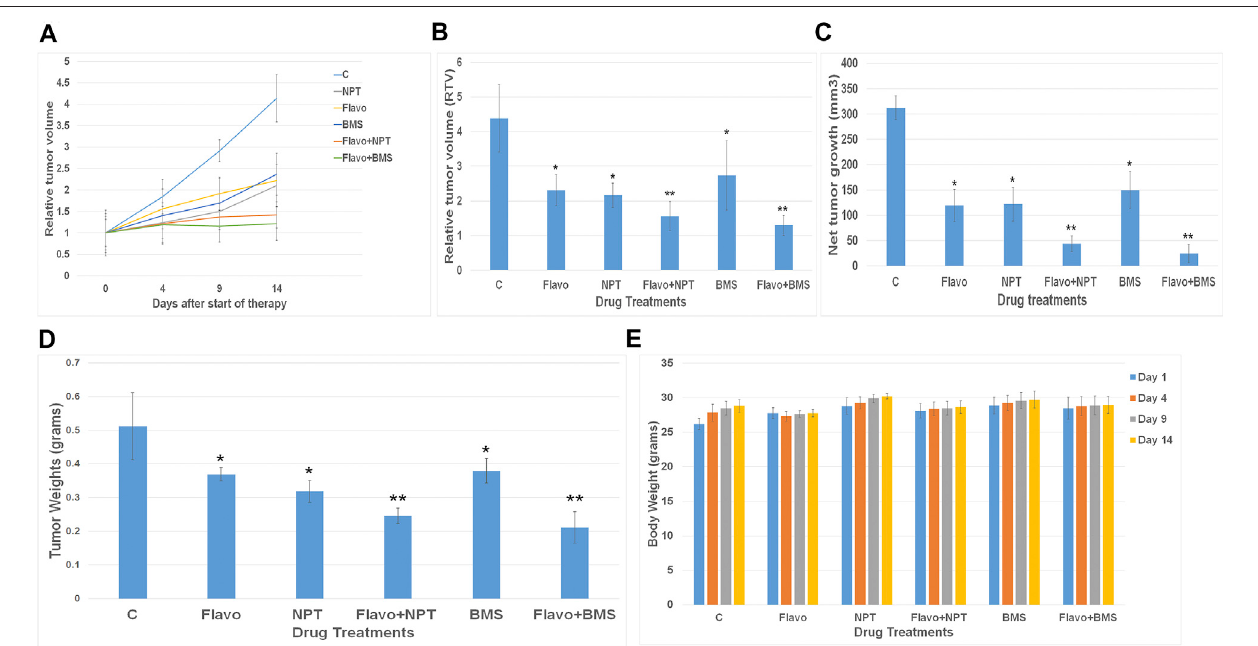
FIGURE4| – Xenografttumor growthinhibitionof fl avopiridolalone andincombinationwithchemotherapy ortargeted therapy.Highc-MycexpressingOE19 cells weresubcutaneouslyinjectedinnudemiceandtreatedwith fl avopiridol(Flavo)alone(5 mg/kgin100 µlof0.1%DMSO,5timesaweekfor2